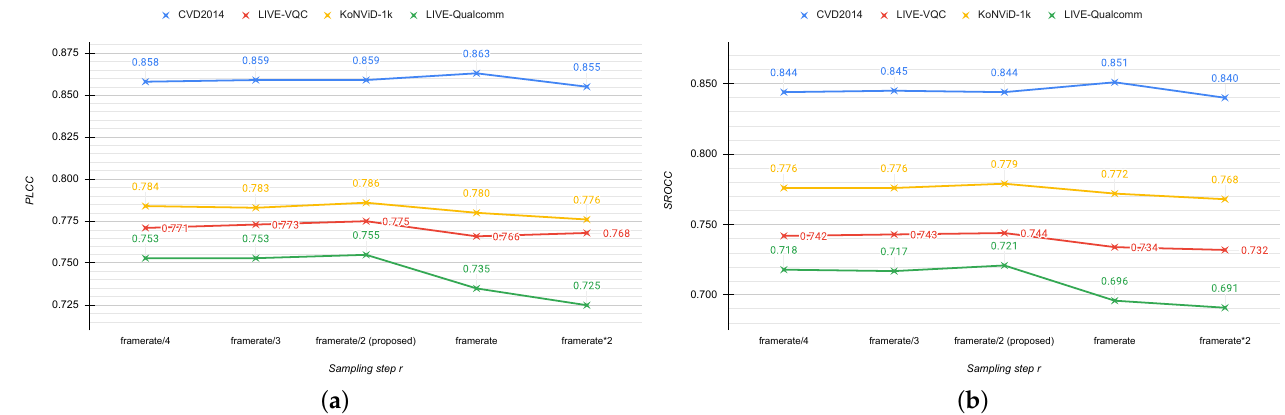
Figure 10. Mean PLCC ( a ) and SROCC ( b ) computed across 100 train–test combinations on the considered databases for different sampling step ( r ) values in the proposed frame sampling algorithm.